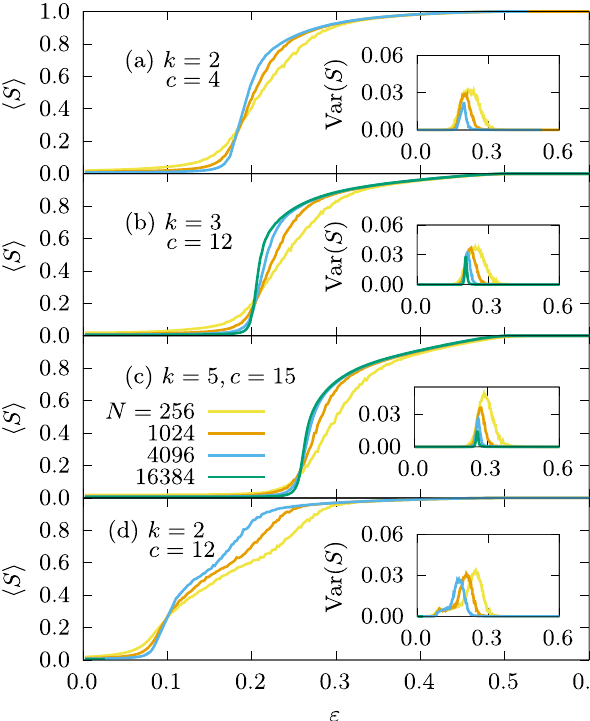
Fig. 8 Behaviour of the mean relative size of the largest cluster for hypergraphs on lattices. Mean relative size of the largest cluster h S i as a function of the con fi dence ε for the HOID model on different lattice-like topologies for different system sizes. Case a nearest-neighbour square lattice with hyperedge size k = 2 and connectivity c = 4, cases b and c spatial hypergraphs de fi ned in the “ Methods ” section, with k = 3, c = 12 and k = 5, c = 15, and case d square lattice with k = 2 and up to third nearest- neighbour interactions, i.e., c = 12.